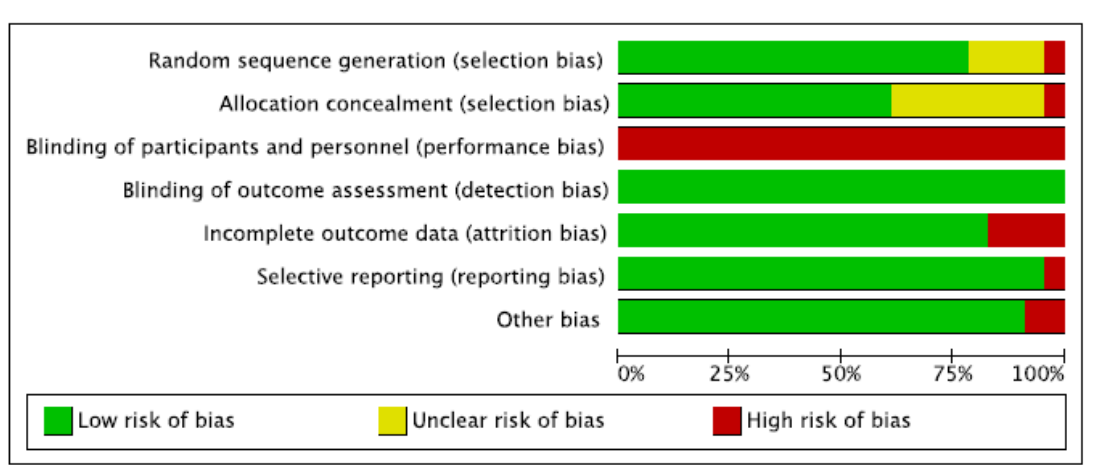
Figure 3. Overall risk of each type of bias.